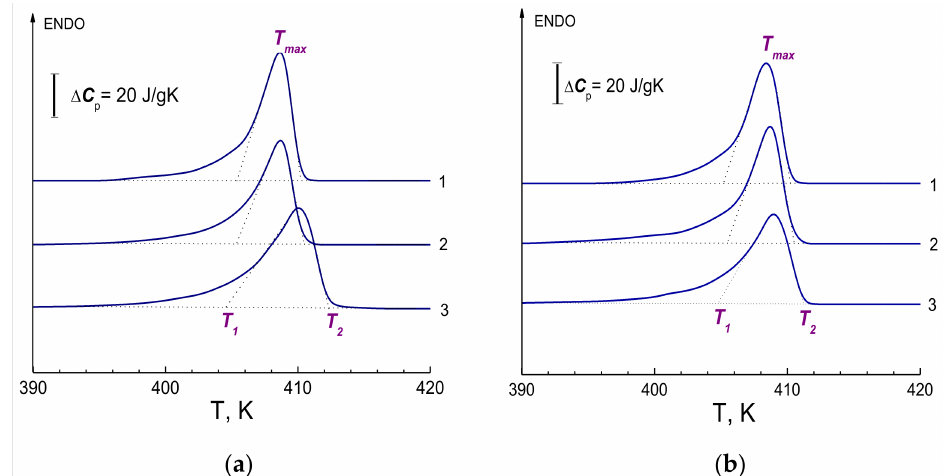
Figure 6. DSC curves obtained on the xerogel samples: ( a ) from decalin; ( b ) from vaseline oil. The data were obtained for samples of the same weight (2.5 mg) at different heating rates: 0.31 K/min (curve 1); 1.25 K/min (2); 5 K/min